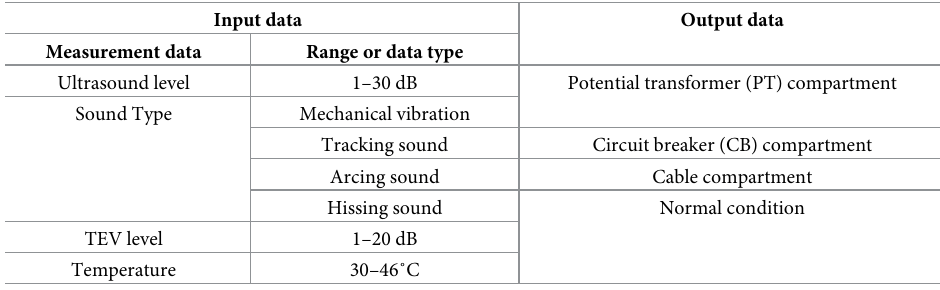
Table 1. CBM data from switchgears for classification of abnormal